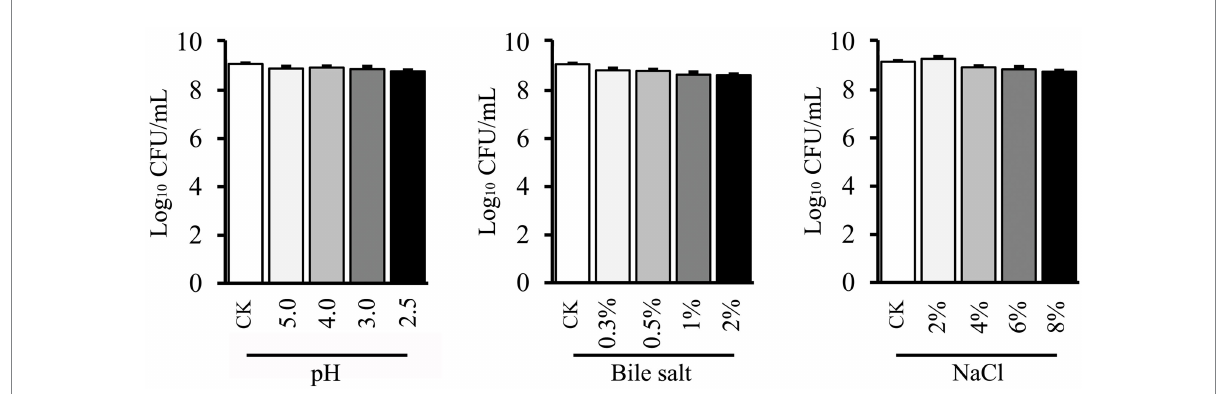
FIGURE 3 Effect of low pH, bile salt, and NaCl on viable count of Lactobacillus plantarum GXL94.